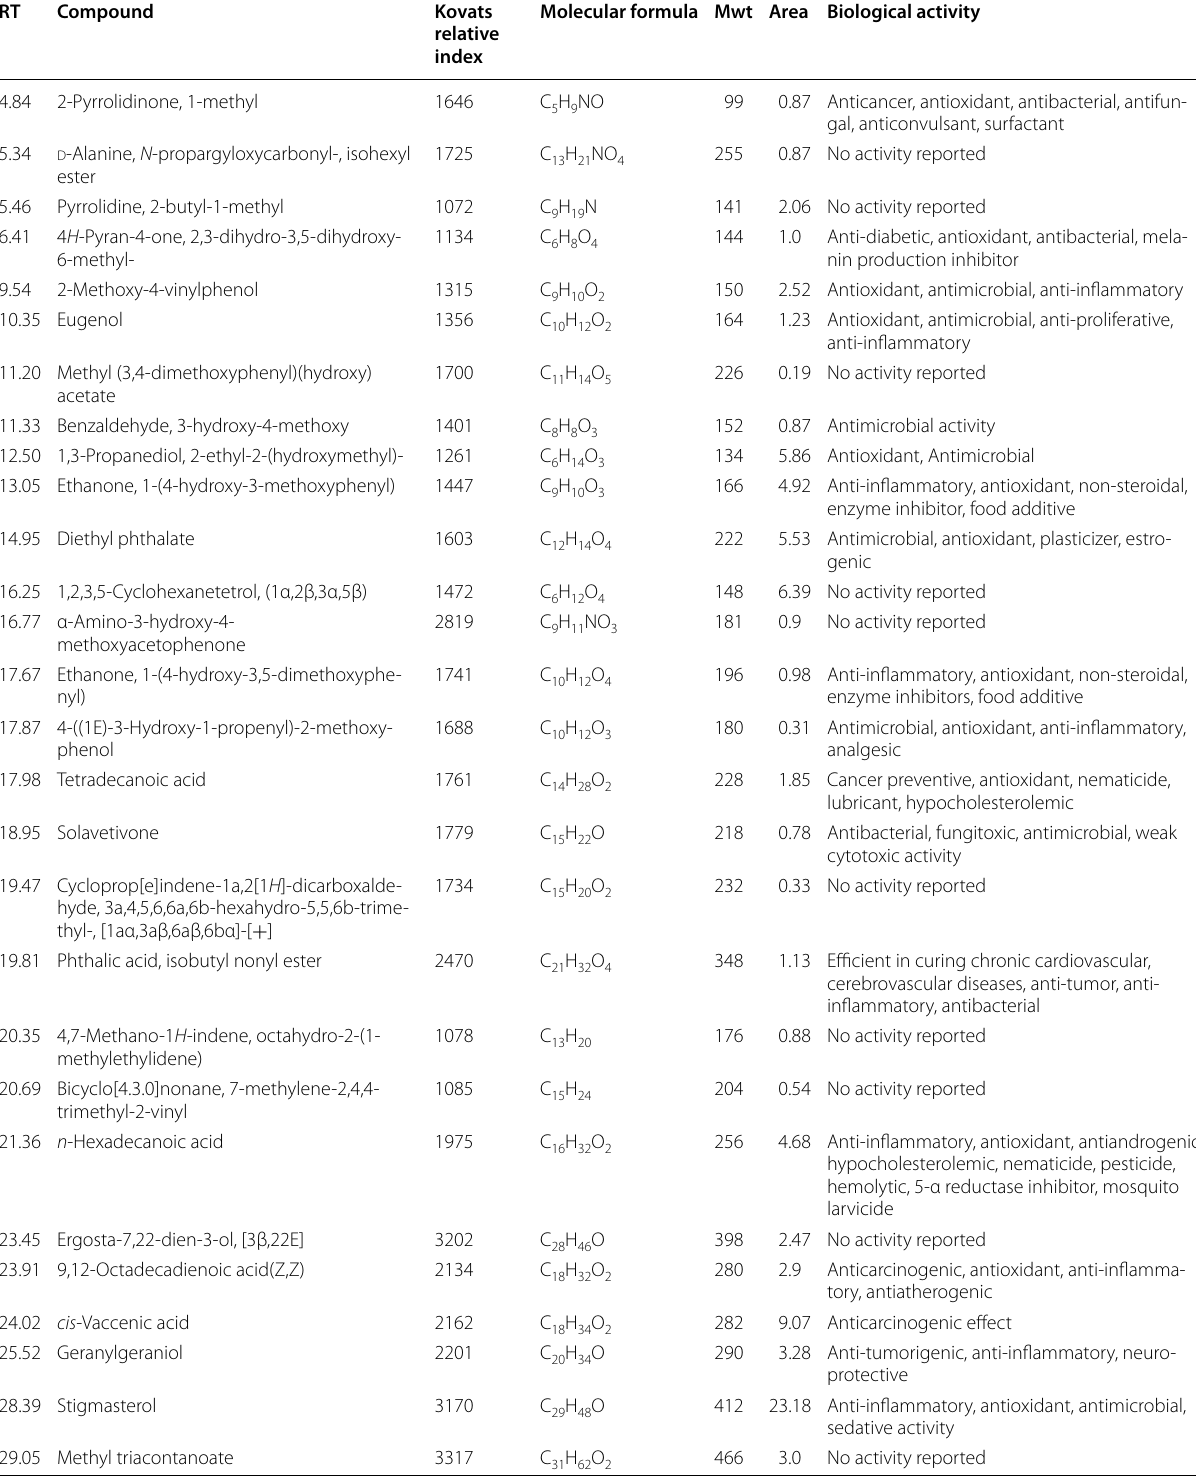
Table 2 Phytochemical constituents identified in root methanolic extracts of Solanum khasianum by GC–MS analysis and mass spectra of NIST